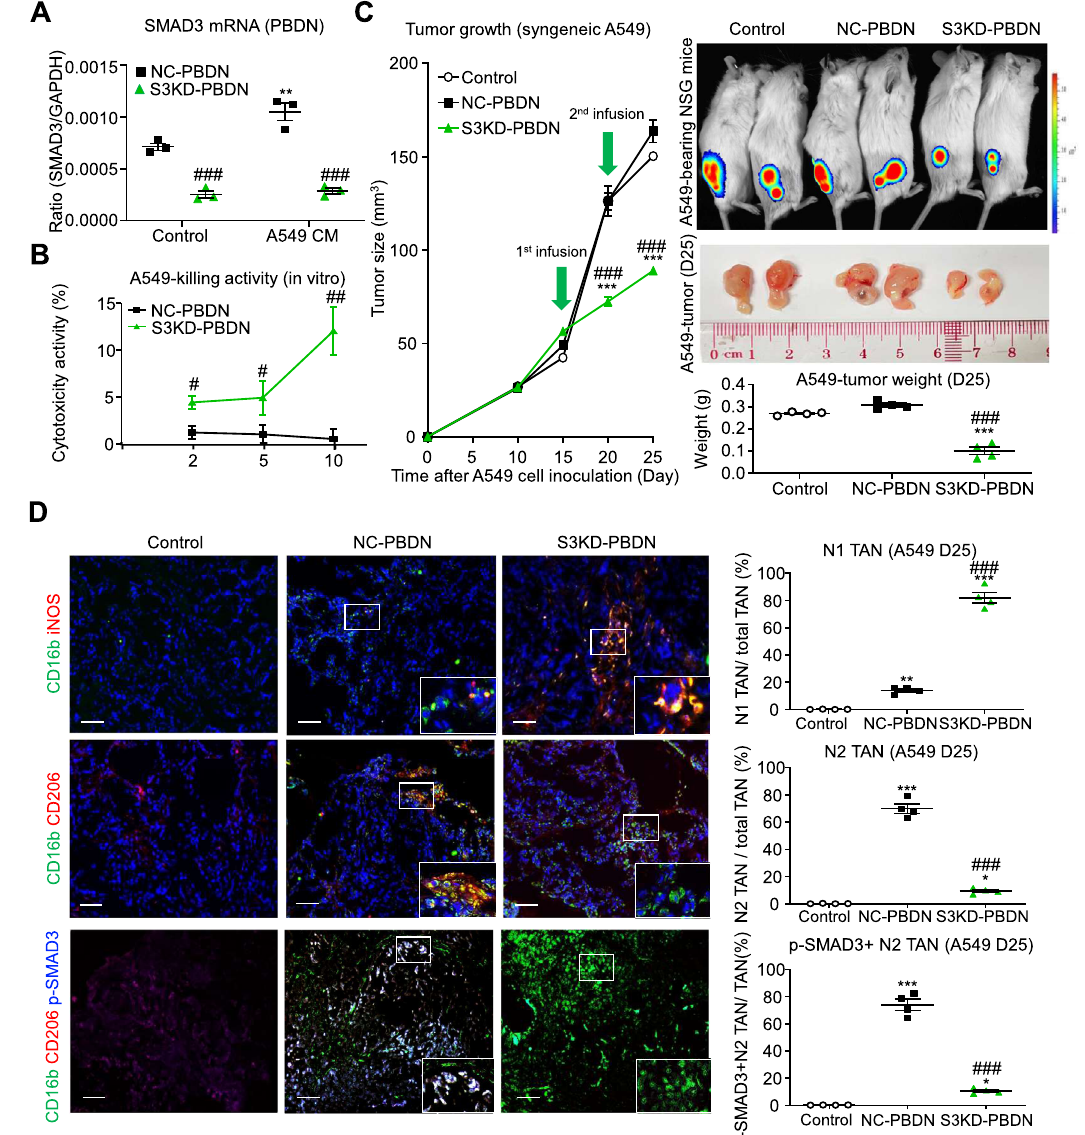
Fig. 7 | Neutrophil-speci fi c silencing of SMAD3 enhances an N1 phenotype in NSCLC. A RT-PCR analysis showing that transfection of human PBDN with SMAD3 siRNA (S3KD-PBDN), but not with nonsense control siRNA (NC-PBDN), suppressesbasal(control)andA549conditionedmedium(A549CM)stimulatedto increase in SMAD3 expression (** P <0.01 vs. Control, ### P <0.001 vs. NC-PBDN, n =3independent samples, one-wayANOVA). B Co-culturestudiesshow enhanced cytotoxicity of S3KD-PBDN towards the human NSCLC cell line A549 (** P <0.01, *** P <0.001, n =3 independent samples, two-tailed t -test). C , D NSG immunocom- promised mice were inoculated with A549 cells and then received injections of human NC-PBDN or S3KD-PBDN on days 15 and 20 and then killed on day 25. C AdoptivetransferofS3KD-PBDNcausedasigni fi